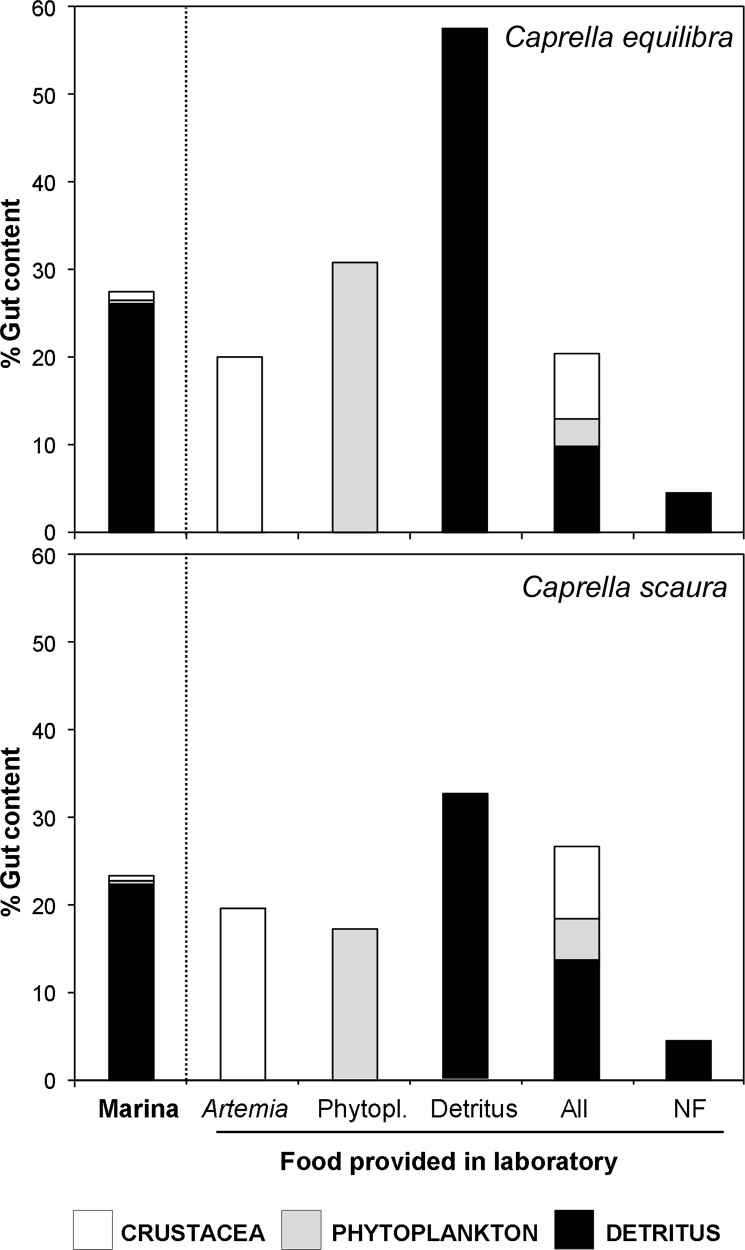
Total area occupied by the gut content in the whole digestive tract of Caprella equilibra and C. scaura.‘Marina’ includes data of the field populations directly fixed after collection. Treatments represent the different feed provided in laboratory conditions: Artemia nauplii, Detritus, Phytoplankton, All feed provided together (All), and no feed provided (NF). The bars indicate the percentage of each item observed in the gut under the microscope (Crustacea, Phytoplankton and Detritus). The Crustacea are represented by copepods in specimens from the field populations of the marinas and Artemia in those maintained in laboratory conditions fed with Artemia.